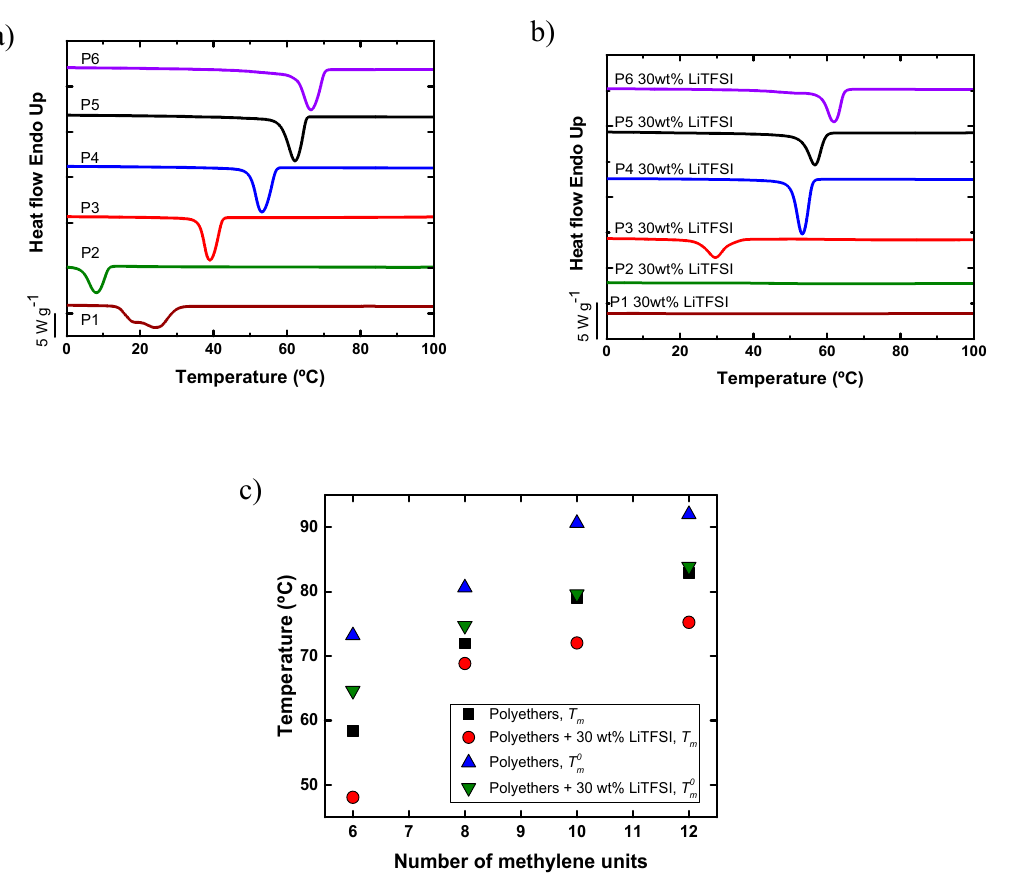
Figure 2. ( a ) Differential scanning calorimetry (DSC) cooling scans of neat aliphatic polyethers, ( b ) DSC cooling scans of polymer electrolytes composed of aliphatic polyethers including 30 wt % LiTFSI, ( c ) experimental melting peak values ( T m ) (determined during the second DSC heating runs) and equilibrium melting point values ( T m 0 ) determined by the Hoffman–Weeks extrapolation procedure (see Supplementary Information) after isothermal crystallization.